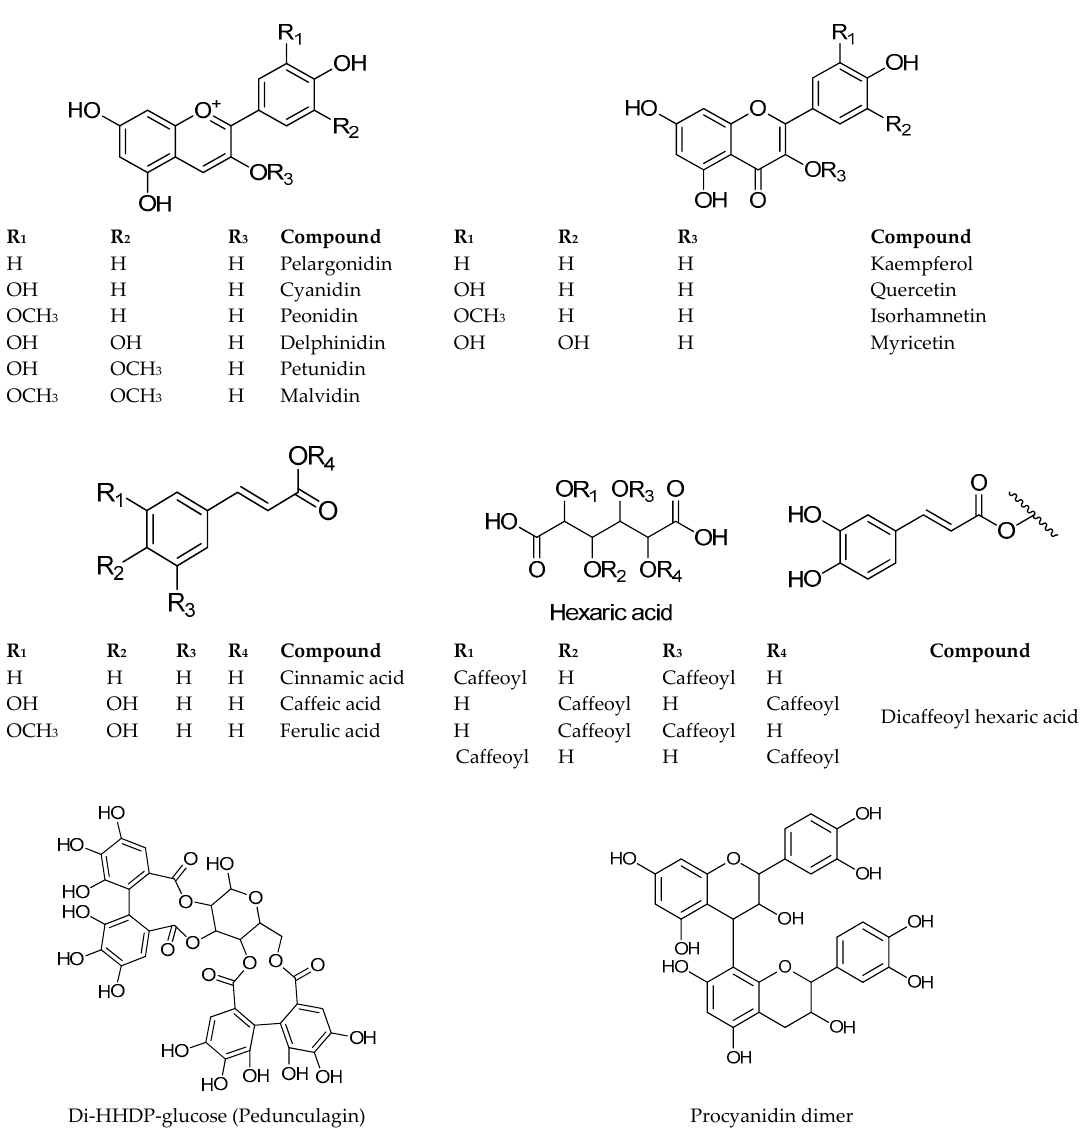
Figure 6. Main group of phenolic compounds occurring in Berberis and Fragaria chiloensis . Patagonia Berberis microphylla , the main anthocyanin